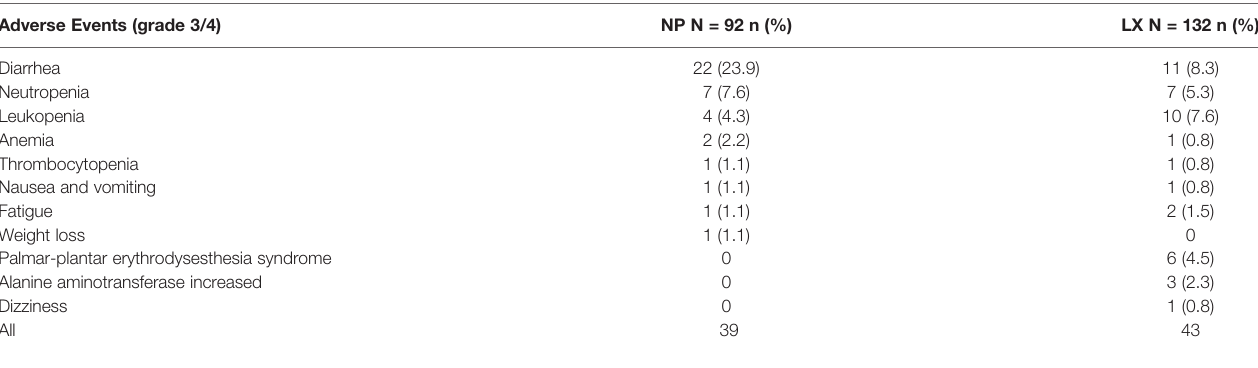
TABLE 2 | Adverse events (grade 3/4).